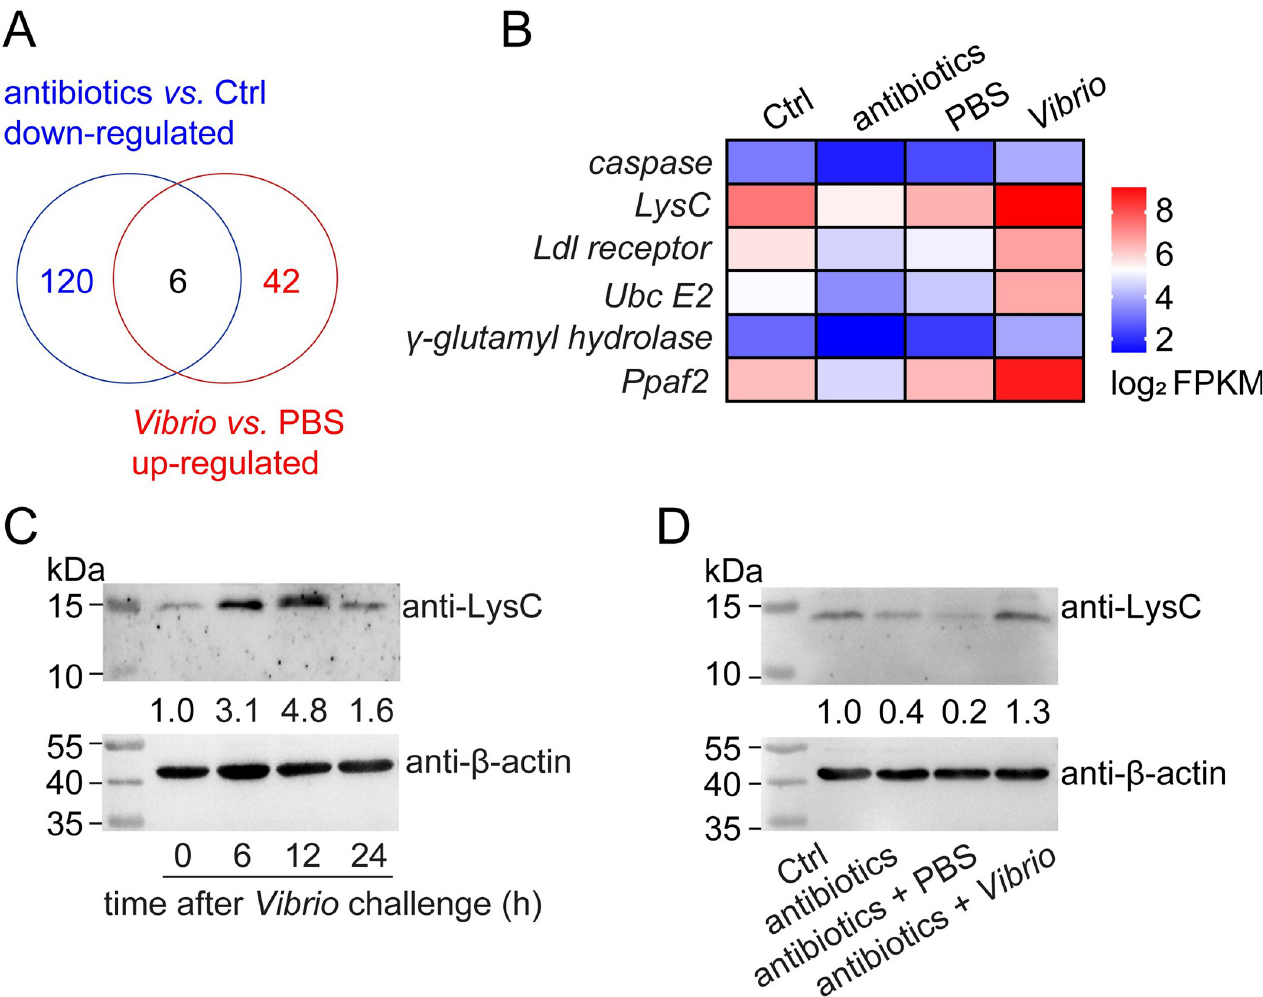
Fig 1. Identification of LysC as a key factor in shrimp intestinal immunity. (A) Venn diagram of the overlap of two sets of differentially expressed genes. Transcriptome sequencing was performed to screen the genes whose expression was induced after V . anguillarum oral challenge (12 h after challenge) and suppressed after antibiotic feeding (3 d after the treatment). Each group consisted of at least 30 animals. Three biological replicates were performed. Only the genes with an FPKM � 2 in the control group were considered as valid. Differential expression was accepted with a fold change � 2 and an adjusted p value � 0.05. (B) Heat map showing the expression level of differentially expressed genes. The mean of the average FPKM value from three biological replicates of each group for each gene were shown after taking the logarithm. LysC, C-type lysozyme; Ldl receptor, low-density lipoprotein receptor; Ubc E2, ubiquitin- conjugating enzyme E2 R2; Ppaf2, phenoloxidase-activating factor 2. (C) Temporal expression profiles of LysC protein after oral challenge. Bacterial suspension (5 × 10 6 CFU) was introduced orally into the shrimp intestine. LysC protein level in intestine was detected at indicated time after challenge, with β -actin as the internal reference. (D) Expression level of the LysC protein after antibiotic treatment and subsequent V . anguillarum challenge. The mixture of antibiotics was introduced into shrimp intestine, with water as control. Bacteria were delivered into intestine 3 d later. LysC level was detected 3 d after antibiotics treatment or 12 h after bacterial infection. The western blotting images are representative of three independent replicates. Gray values were analyzed using ImageJ software. Each sample originated from at least five shrimp.